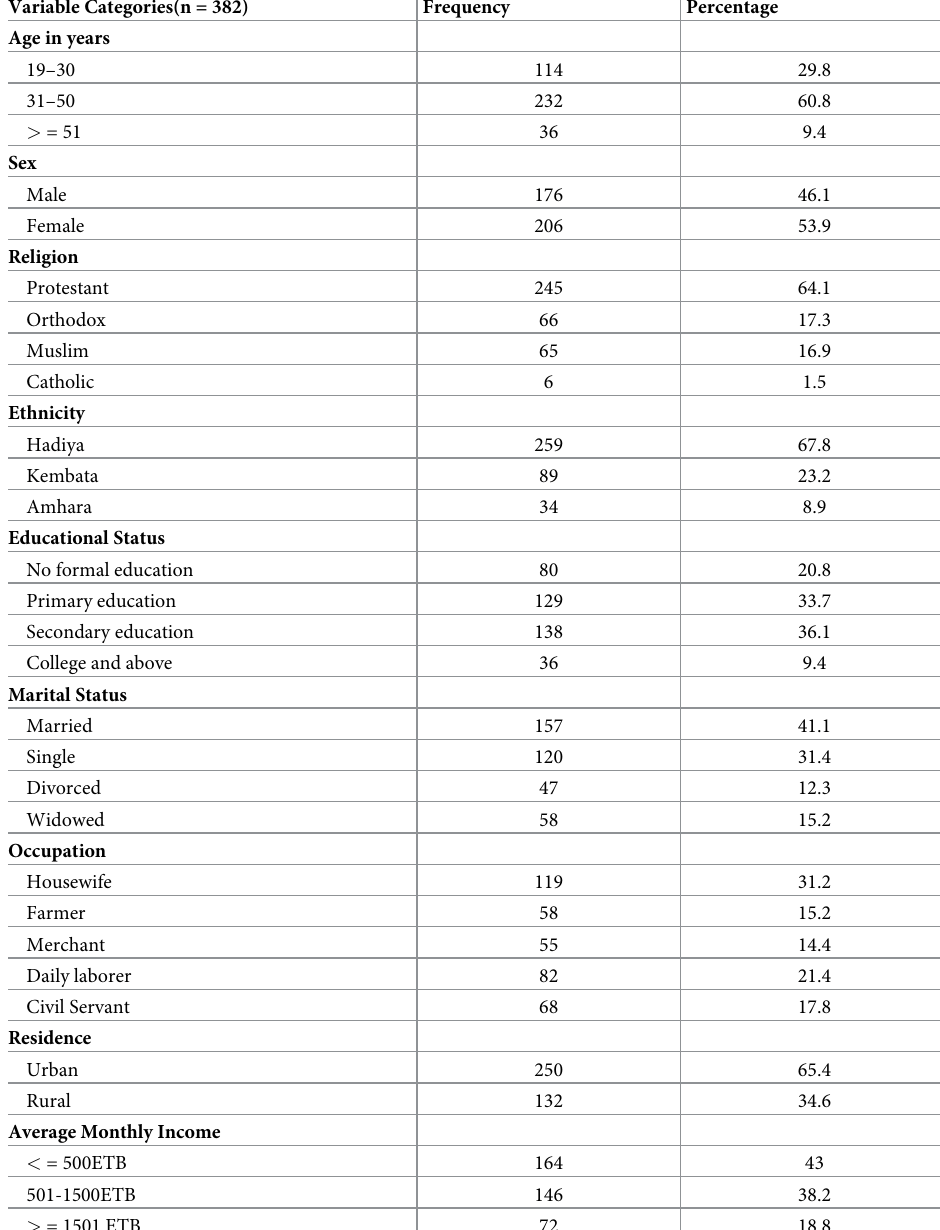
Table 1. Socio-demographic characteristics of clients receiving HAART at Nigist Elleni Mohammed Memorial Referral Hospital (NEMMRH), Southern Ethiopia, January 20 –March 20, 2020. Variable Categories(n =